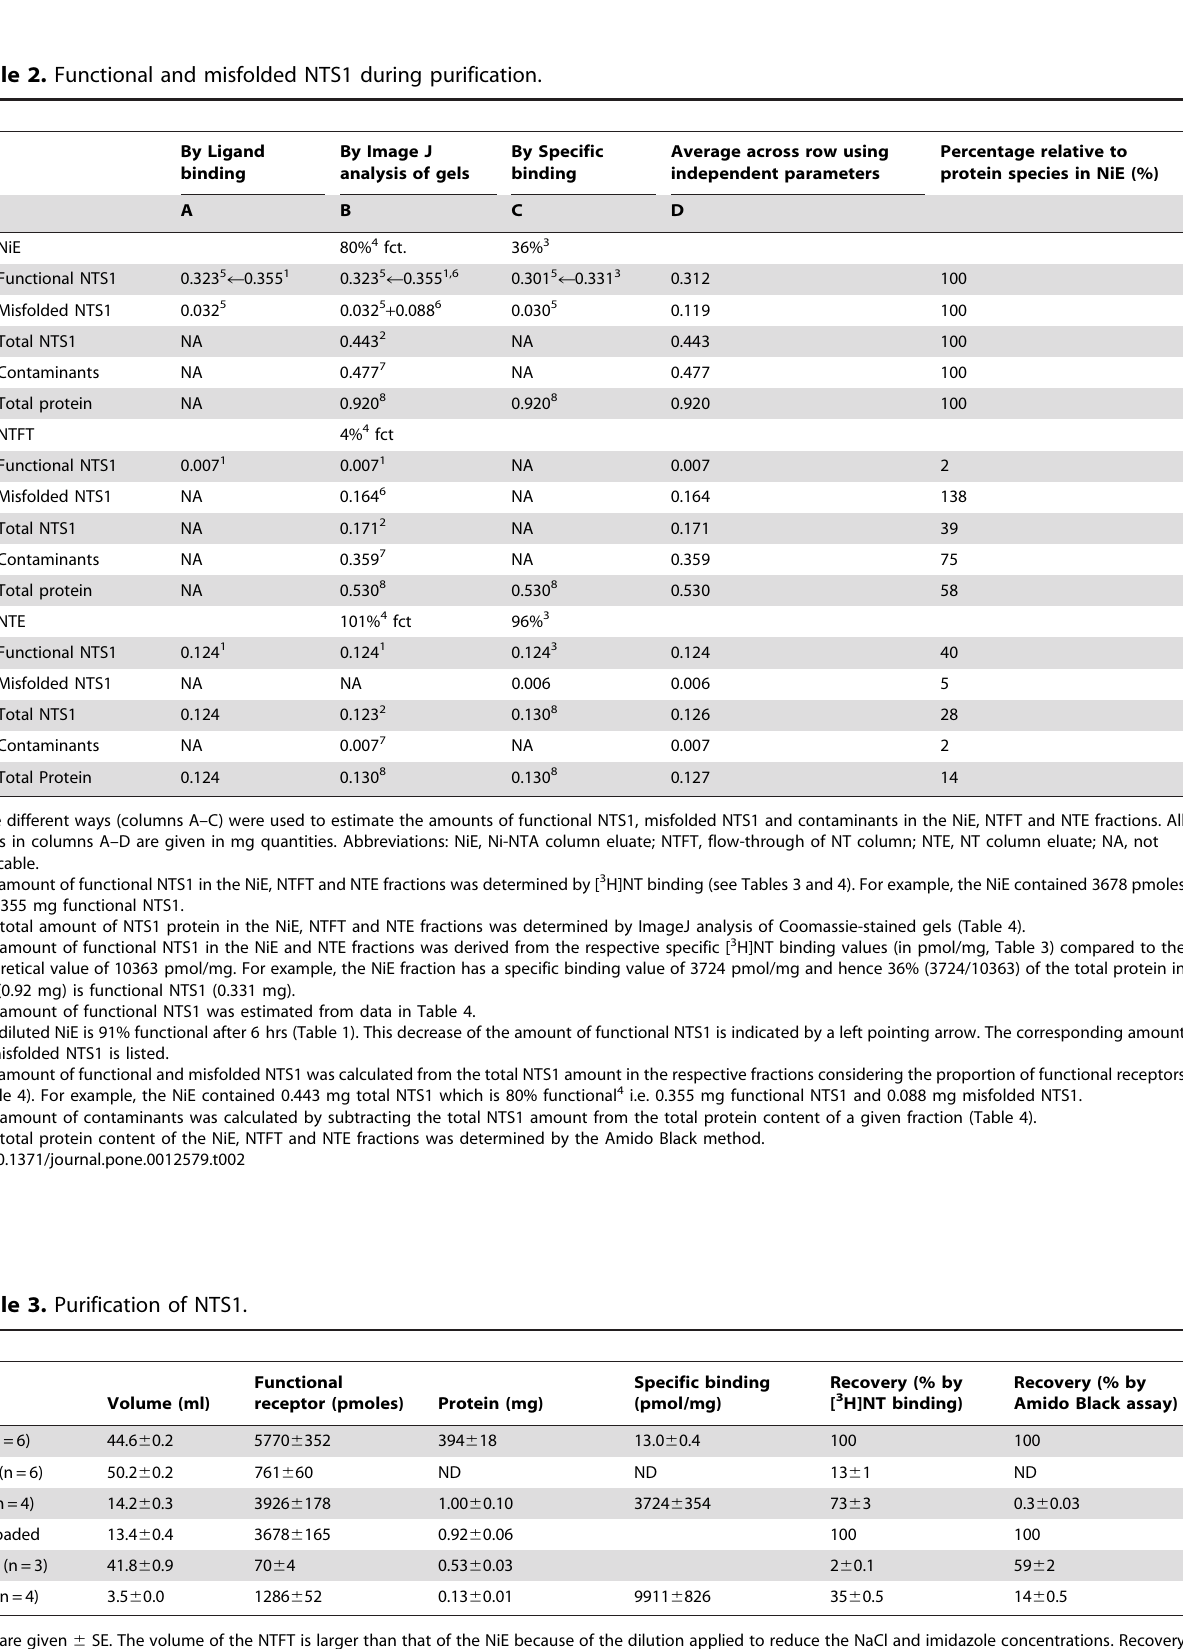
Table 2. Functional and misfolded NTS1 during purification.